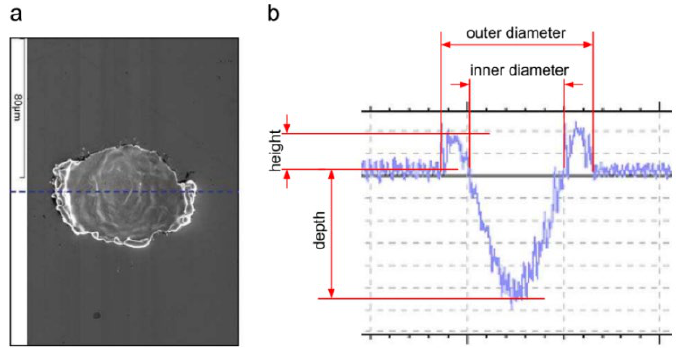
Figure 2. The dimple shape: ( a ) SEM micrograph and; ( b ) 2D profile illustrating the outer and inner diameter, depth and height of micro-pores. Reproduced with permission from [37].